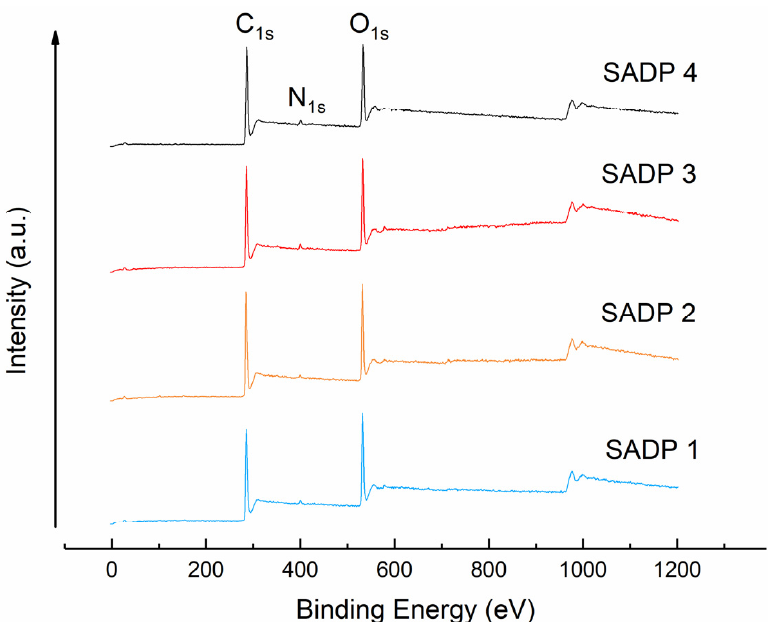
Figure 8. XPS spectra of synthesized SADP adhesives after freezing dry.